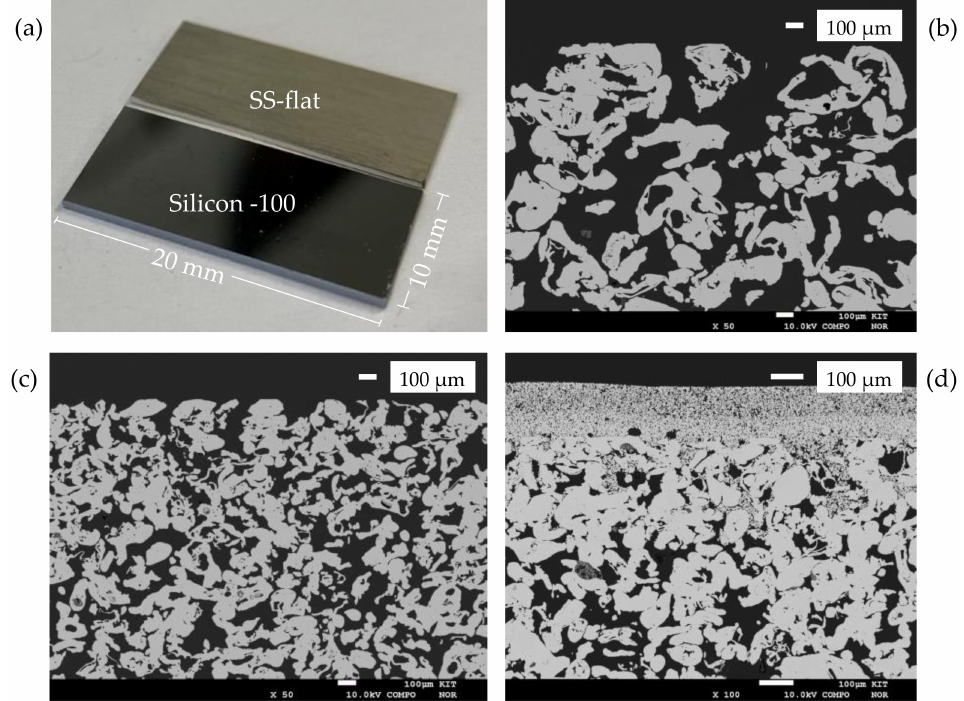
Figure 3. Overview of the used substrates: ( a ) silicon and stainless steel (SS) flat substrates; ( b ) 52% porous SS substrate; ( c ) 40% porous SS substrate; and ( d ) fine porous multilayer SS